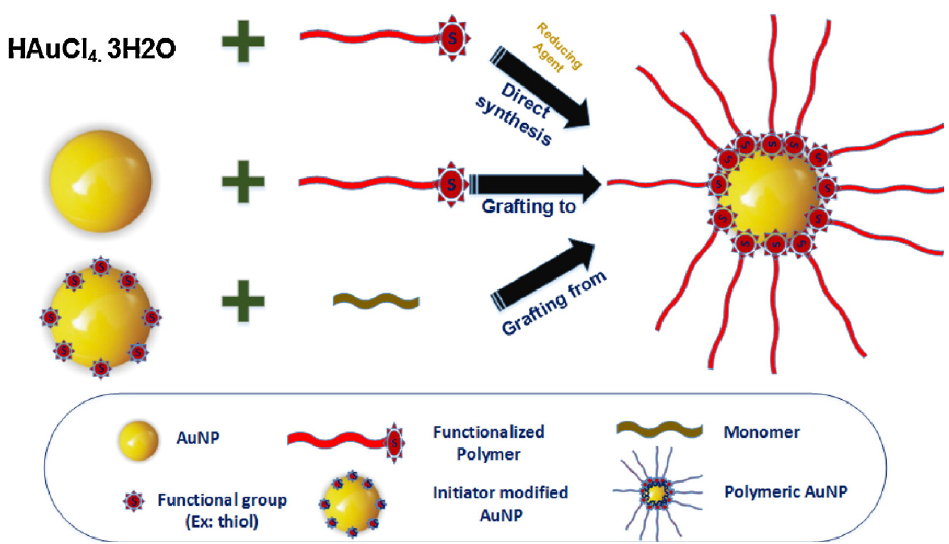
Figure 2. A schematic representing the various synthetic methods involved for polymer AuNPs. Reproduced with permission from [44]. Elsevier, 2015.